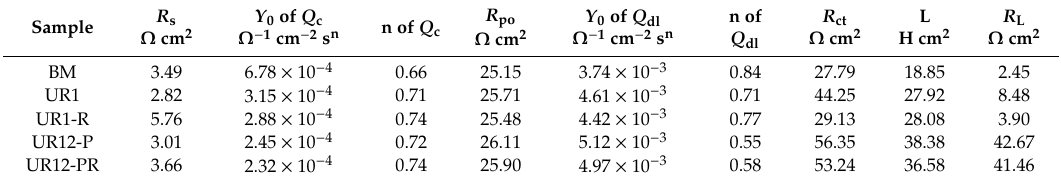
Table 6. Electrochemical parameters fitted from EIS data of samples immersed in the solution for 2 h.